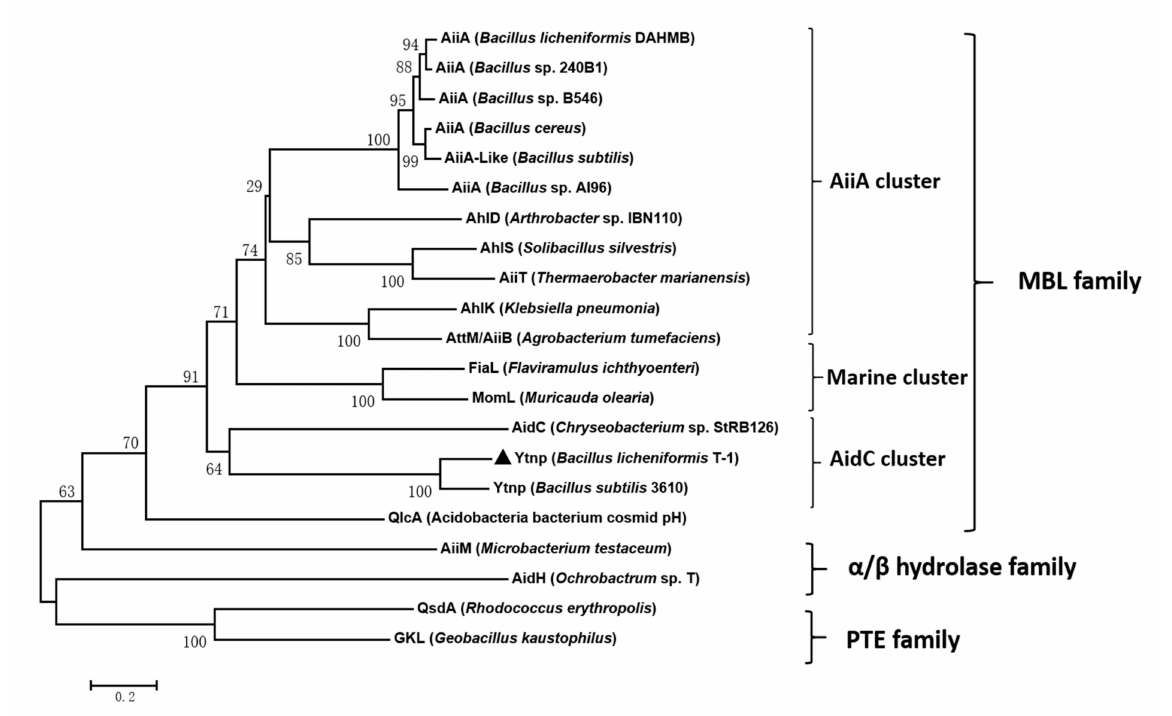
Figure 2. The phylogenetic tree was constructed according to the amino acid sequences of YtnP. The AHL lactonases and AhlD from Arthrobacter sp. (AAP57766.1), AhlK from K. pneumoniae (AAO47340.1), AhlS from Solibacillus silvestris (BAK54003.1), AidC from Chryseobacterium sp. strain StRB126 (BAM28988.1), AidH from Ochrobactrum sp. T63 (ACZ73823.1) Bacillus sp. strain 240B1 (AAF62398.1), Bacillus sp. (AAF62398.1), Bacillus sp. strain AI96 (HM750248.1), AiiM from Microbac- terium testaceum strain StlB037 (YP_004225655.1), AttM/AiiB from A. tumefaciens (AAL13075.1), QlcA from Acidobacteria bacterium cosmid p2H8 (ABV58973.1), QsdA from Rhodococcus erythropolis (AAT06802.1), AiiT from Thermaerobacter maria- nensis (AB935246.1), FiaL from Flaviramulus ichthyoenteri Th78T (WP_034041734.1), MomL from Muricauda olearia (AIY30473), and GKL from Geobacillus kaustophilus (WP_011231002.1). These proteins were classified as the member of the metallo- β - lactamase family (MBL), α / β -hydrolase family, and phosphotriesterase family (PTE). The dendrogram was constructed by the neighbor-joining method using Clustal W. The scale bar represents 0.1 substitutions per amino acid position.